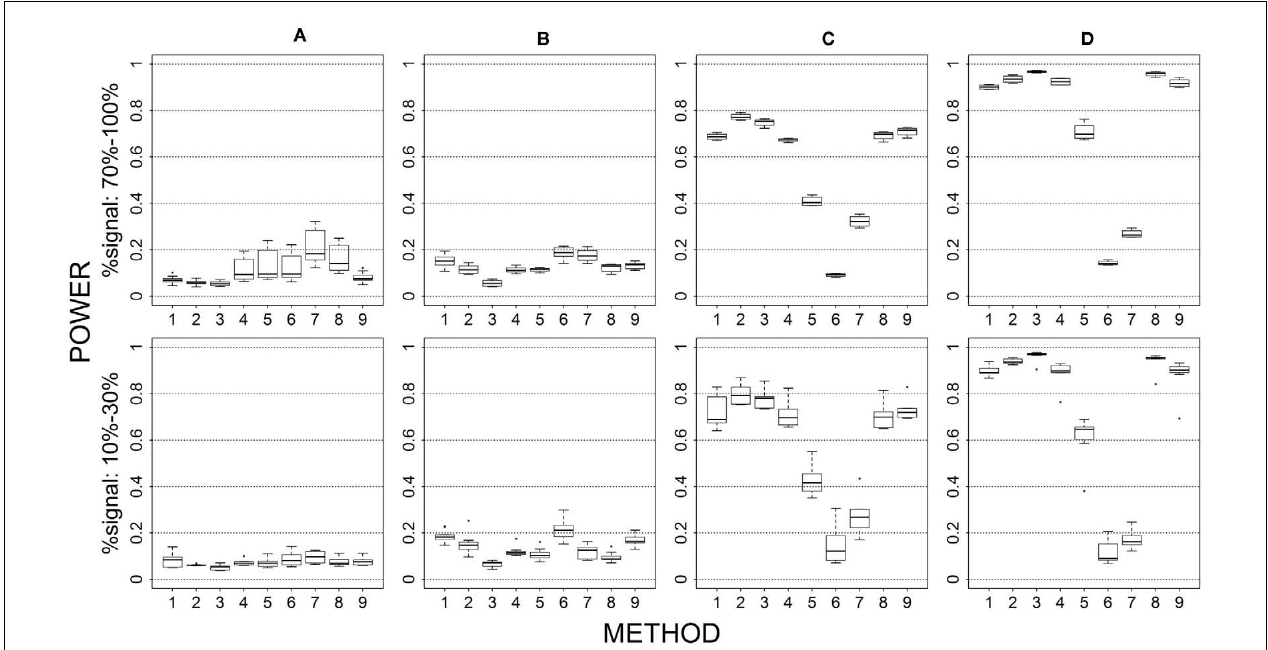
marker-combinations belonging to each average functional allele frequency [ (A) is 0–0.01, (B) is 0.01–0.03, (C) is 0.08–0.10, (D) is 0.16–0.26] and percent-signal category; 1 = CMC01, 2 = CMC05, 3 = SimReg0, 4 = SimReg3, 5 = SimReg4, 6 = SKATsr, 7 = VT, 8 = 2Stage, 9 =